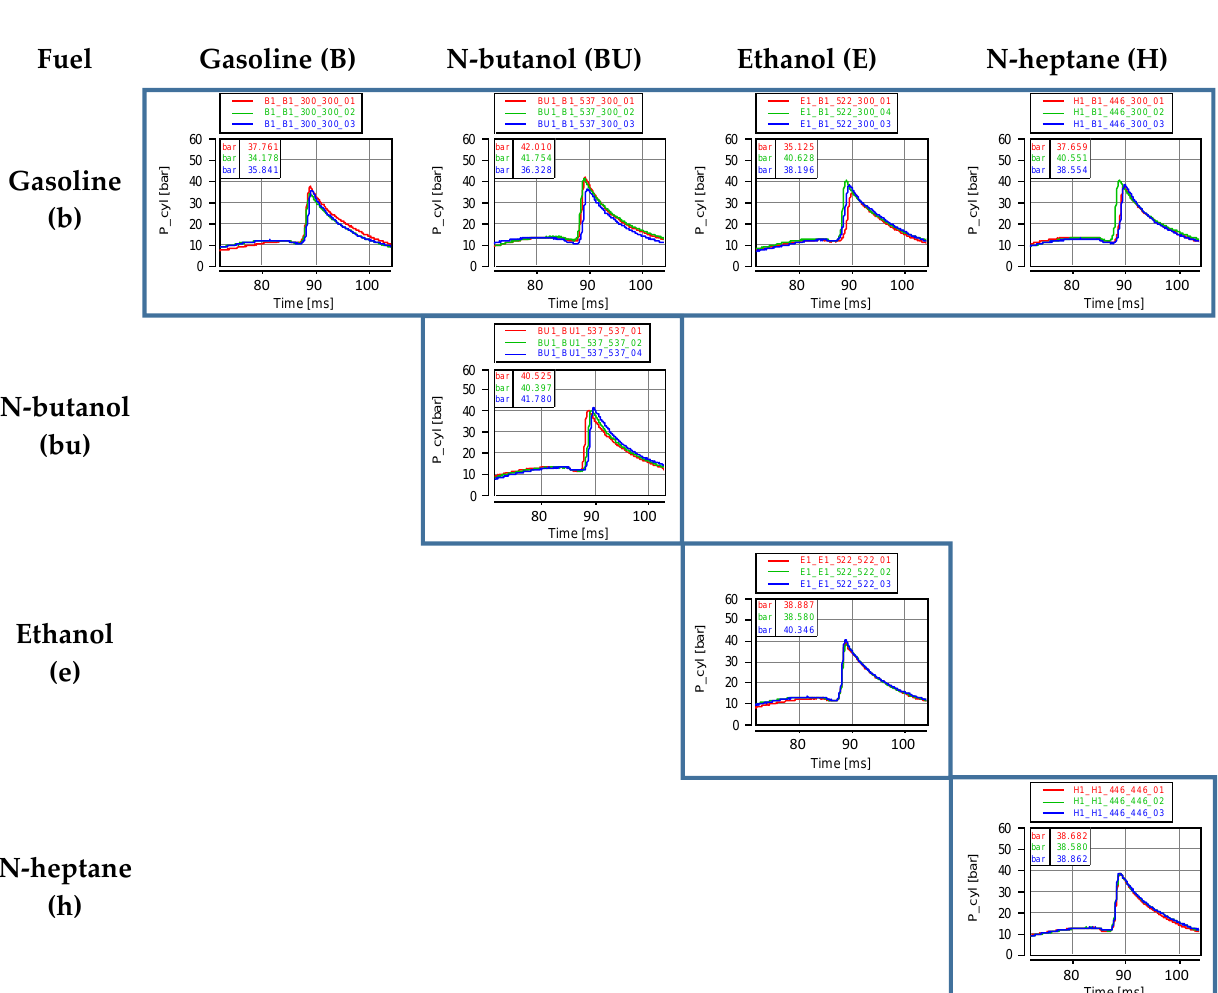
Table 7. Maximum combustion pressure values for representative characteristics, including the greatest relative deviation .